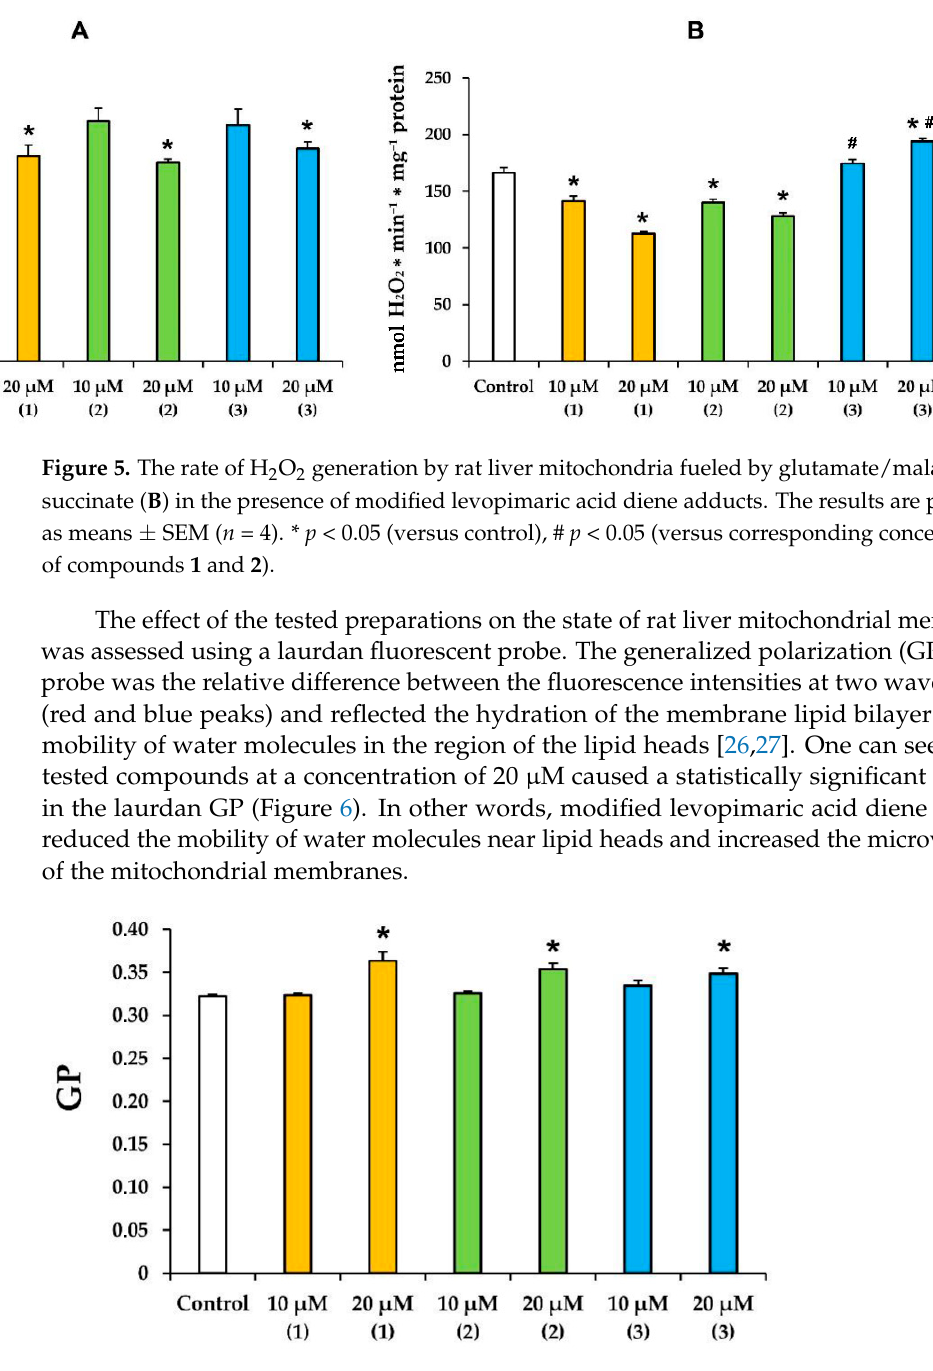
Figure 6. Effects of modified levopimaric acid diene adducts on laurdan GP in mitochondria. The results are presented as means ± SEM ( n = 4). * p < 0.05 (versus control).